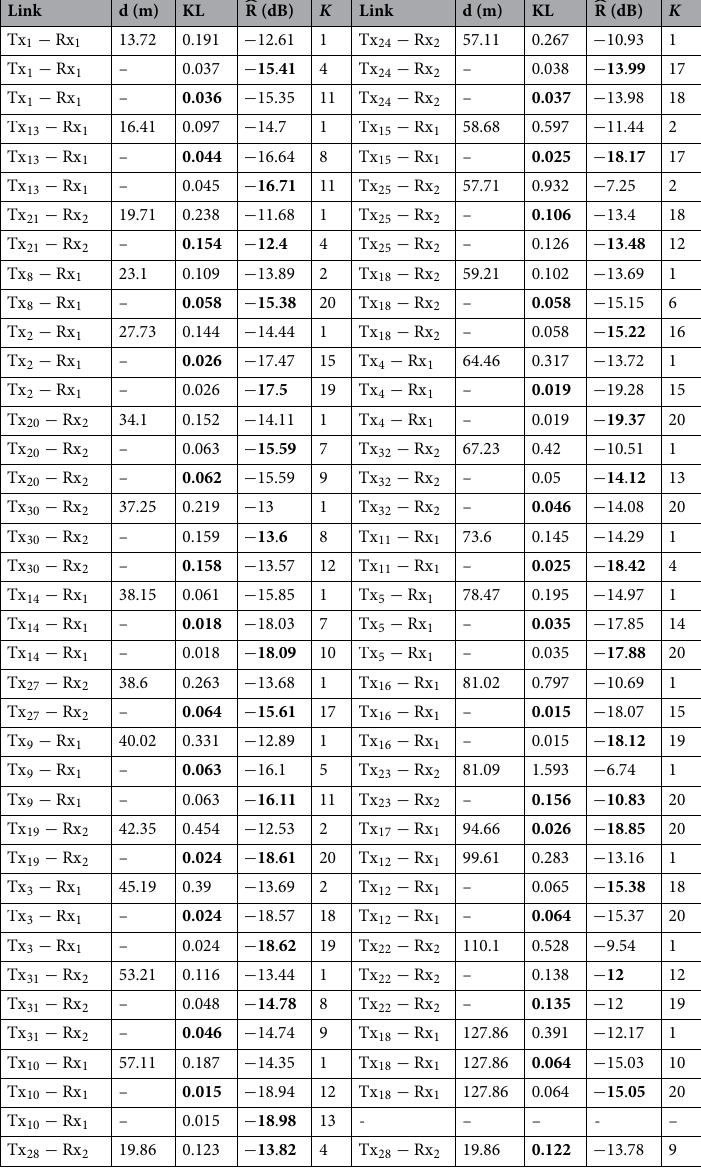
Table 1. Fitting accuracy metrics of GMs with different values of K . Significant values are in